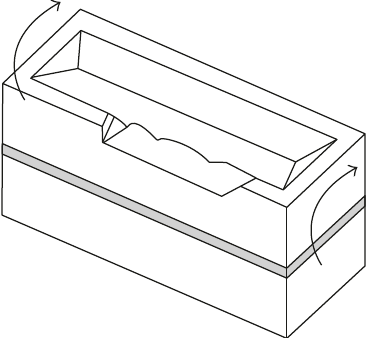
Figure 3: Failure A7: shear crash of the part of the specimen fixed to the clamp. Figure Table 1: Specimen 1: rectified brick 37 × 25 × 23.5cm and foam for masonry.